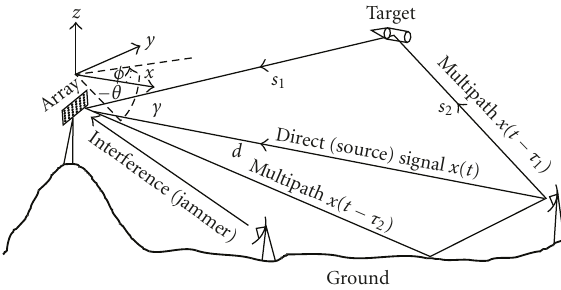
Figure 1: Transmitter and receiver arrangements with an airborne target, a jammer, and one